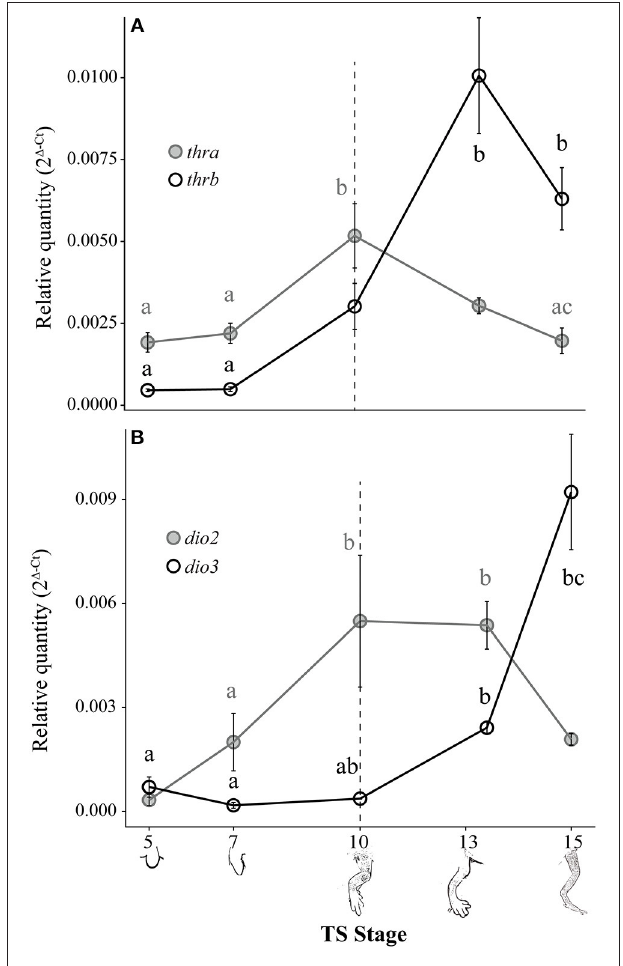
FIGURE 4 | Relative thra and thrb mRNA levels (A) and dio2 and dio3 mRNA levels (B) in the pre-hatching hind limb of E. coqui . Dashed vertical line at TS stage 10 marks when thyroid follicles are first visible in histological sections. Drawings on the x-axis depict sequential formation of the limb. Each expression value is represented as a circle centered on the mean of 5–7 hind limb pairs ± SE. Lower-case letters in gray ( thra and dio2 ) and black ( thrb and dio3 ) indicate significant pairwise differences between groups ( post-hoc Dunn’s test, p < 0.05). See Supplementary Data for a complete list of pairwise comparisons.